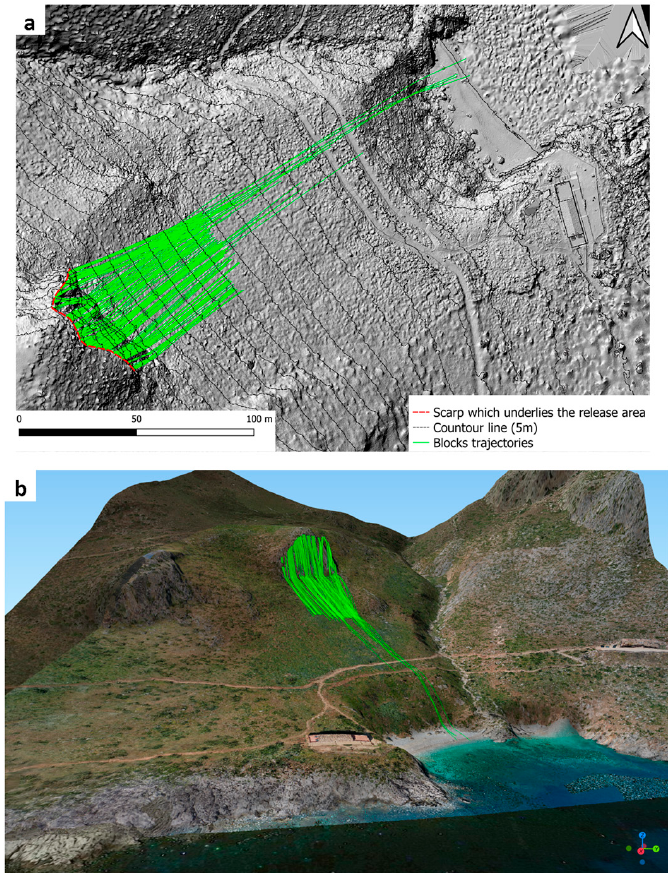
Figure 13. Block trajectories defined by IS GeoMassi: ( a ) in plan and ( b ) in 3D version. The potentially affected areas spread up to the beach for both methods, particularly in the left portion of the analyzed morphological unit. This trend was further noted during the geomorphological and geostructural surveys; most of the simulated blocks stop at the middle of the slope (Figure 13) and on the propagation zone representation (Figure 14). The red frequency has greater representation in this sector. Among the features that affect rockfall energy and the trajectory of the rockfall (slope angle, rock type, slope height, topography, soil cover, and vegetation), the factor that seems to have a greater influence is the inclination of the release area. This is more inclined in the left side of the rocky mass, favoring the free fall of the blocks which have a higher energy in terms of propagation distance. On the right-hand side of the beach, the sedimentary contributions are generally derived from rockfall, which affects the steep rocky side (Figure 5a,b); on the left, the morphological conditions of the slopes seem favorable for the propagation of collapsed boulders from the isolated rocky slope at the back of the